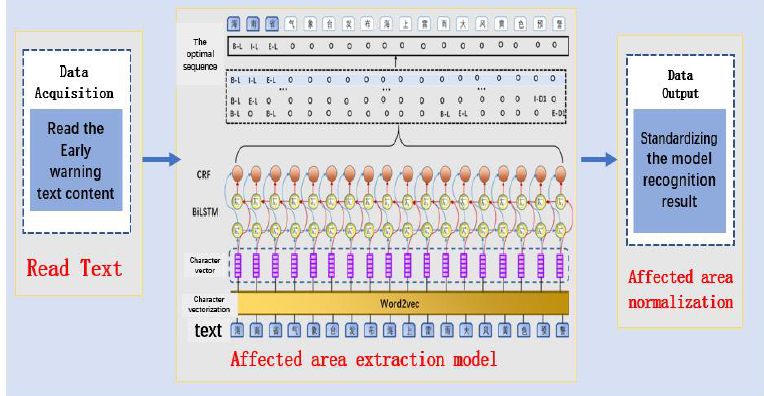
Fig. 3. Extraction process of early warning affected